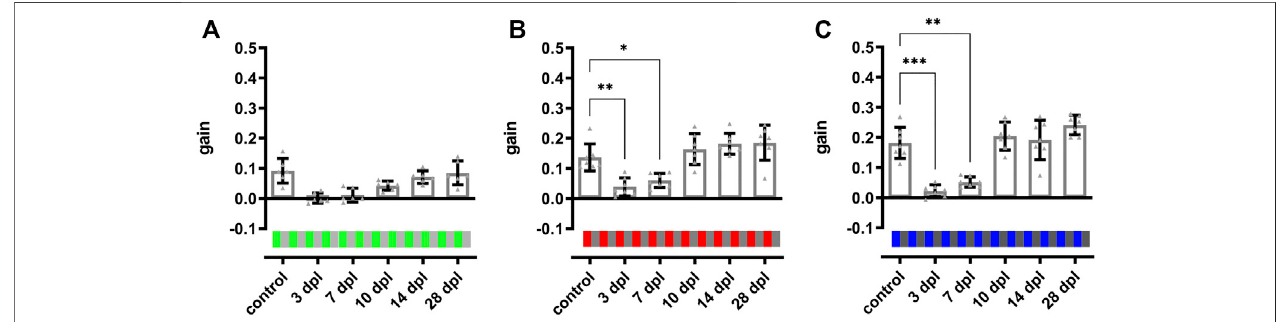
FIGURE 6 | Color vision is restored at 10 days after light lesion. Quanti fi cations of the gain obtained after light lesion for red (B) and blue (C) colored stimuli on an intensity-matchedgrey background (100%/0.2 cpd/15 dps)revealedasigni fi cantreduction at 3and7 dplbut restorationtobaseline levels at 10 dpl.Thequanti fi cation ofthegainforagreenstimulus (A) showedasimilartrendbutwasnotsigni fi cantlydifferent.Individualdataaresummarizedin Table2 .Statistics:alldataarerepresented as mean ± SD, one-way ANOVA with Dunnett ’ s multiple comparison test against control, p < 0.05 (*); 0.01 (**); 0.001 (***) or 0.0001 (****).